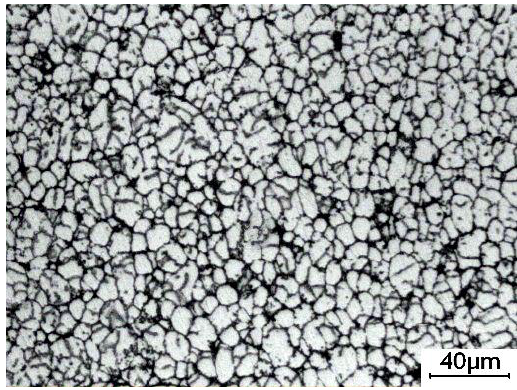
Figure 7. A micrograph of the bulk alloy heated at 750 °C for 60 min and then water-quenched.